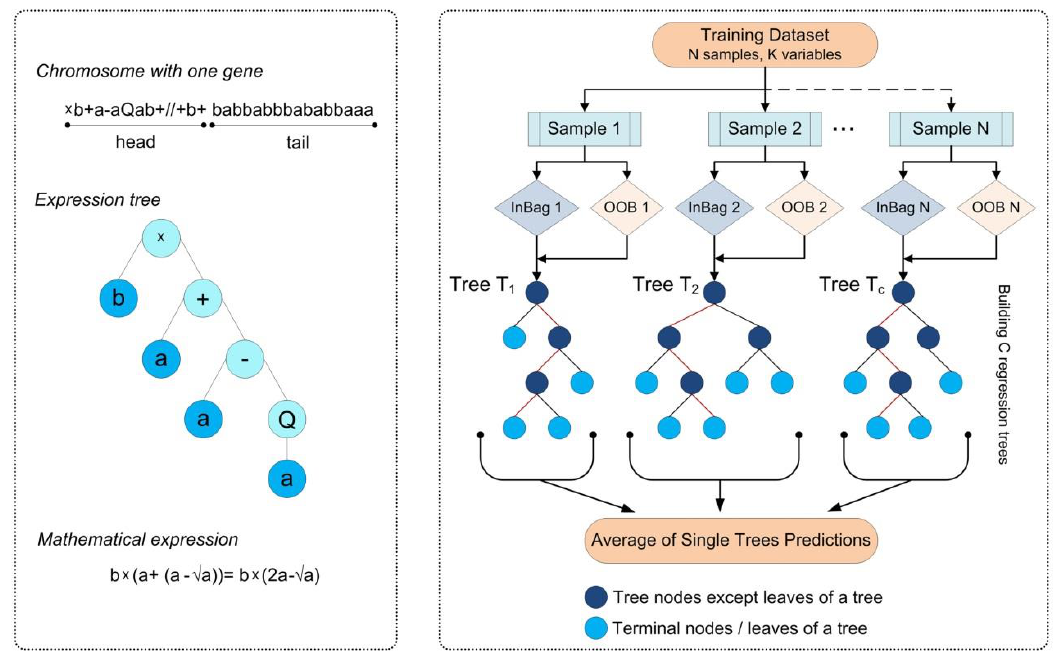
Figure 1. The topological structure of ( a ) gene expression programming (GEP) and ( b ) random forest regression (RFR) models.